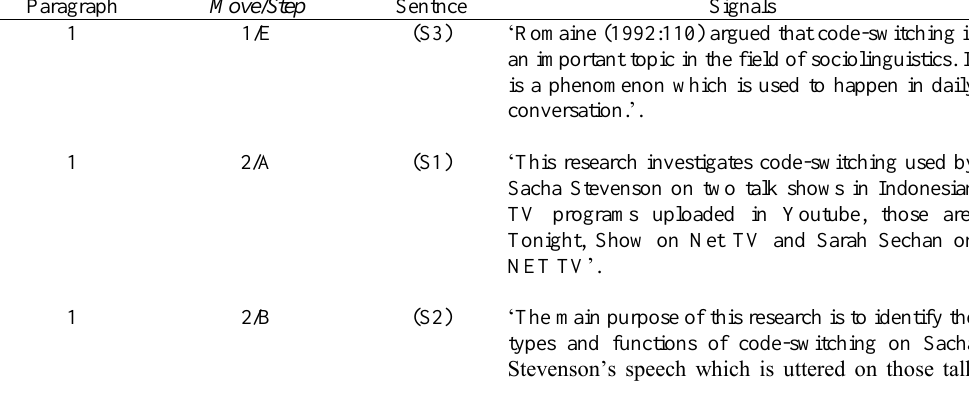
Move and Step in research article introduction in research article